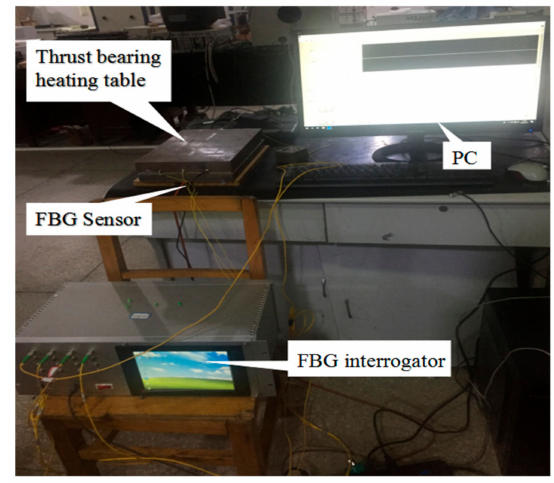
Figure 10. The architecture of the testbed.